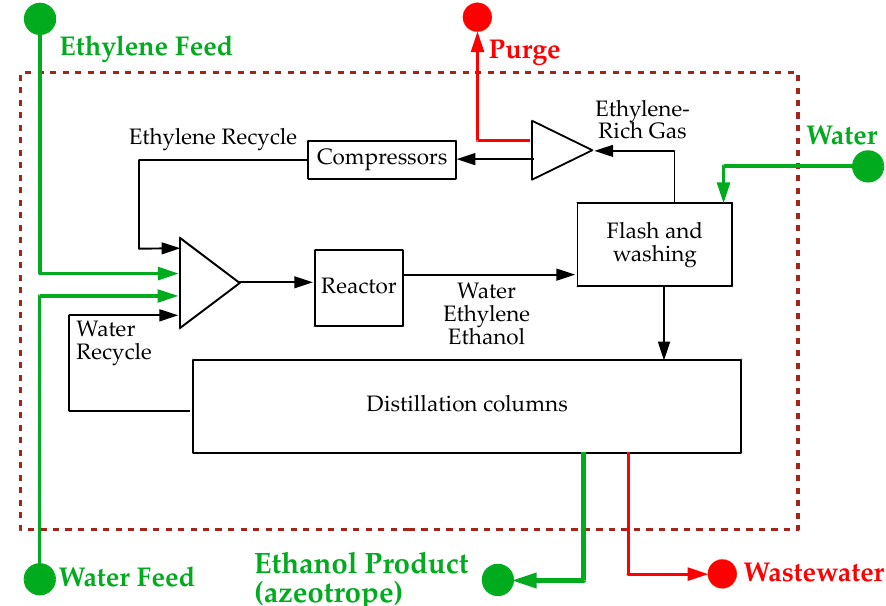
Figure 2. Ethanol production from ethylene summarised from the example in [61].